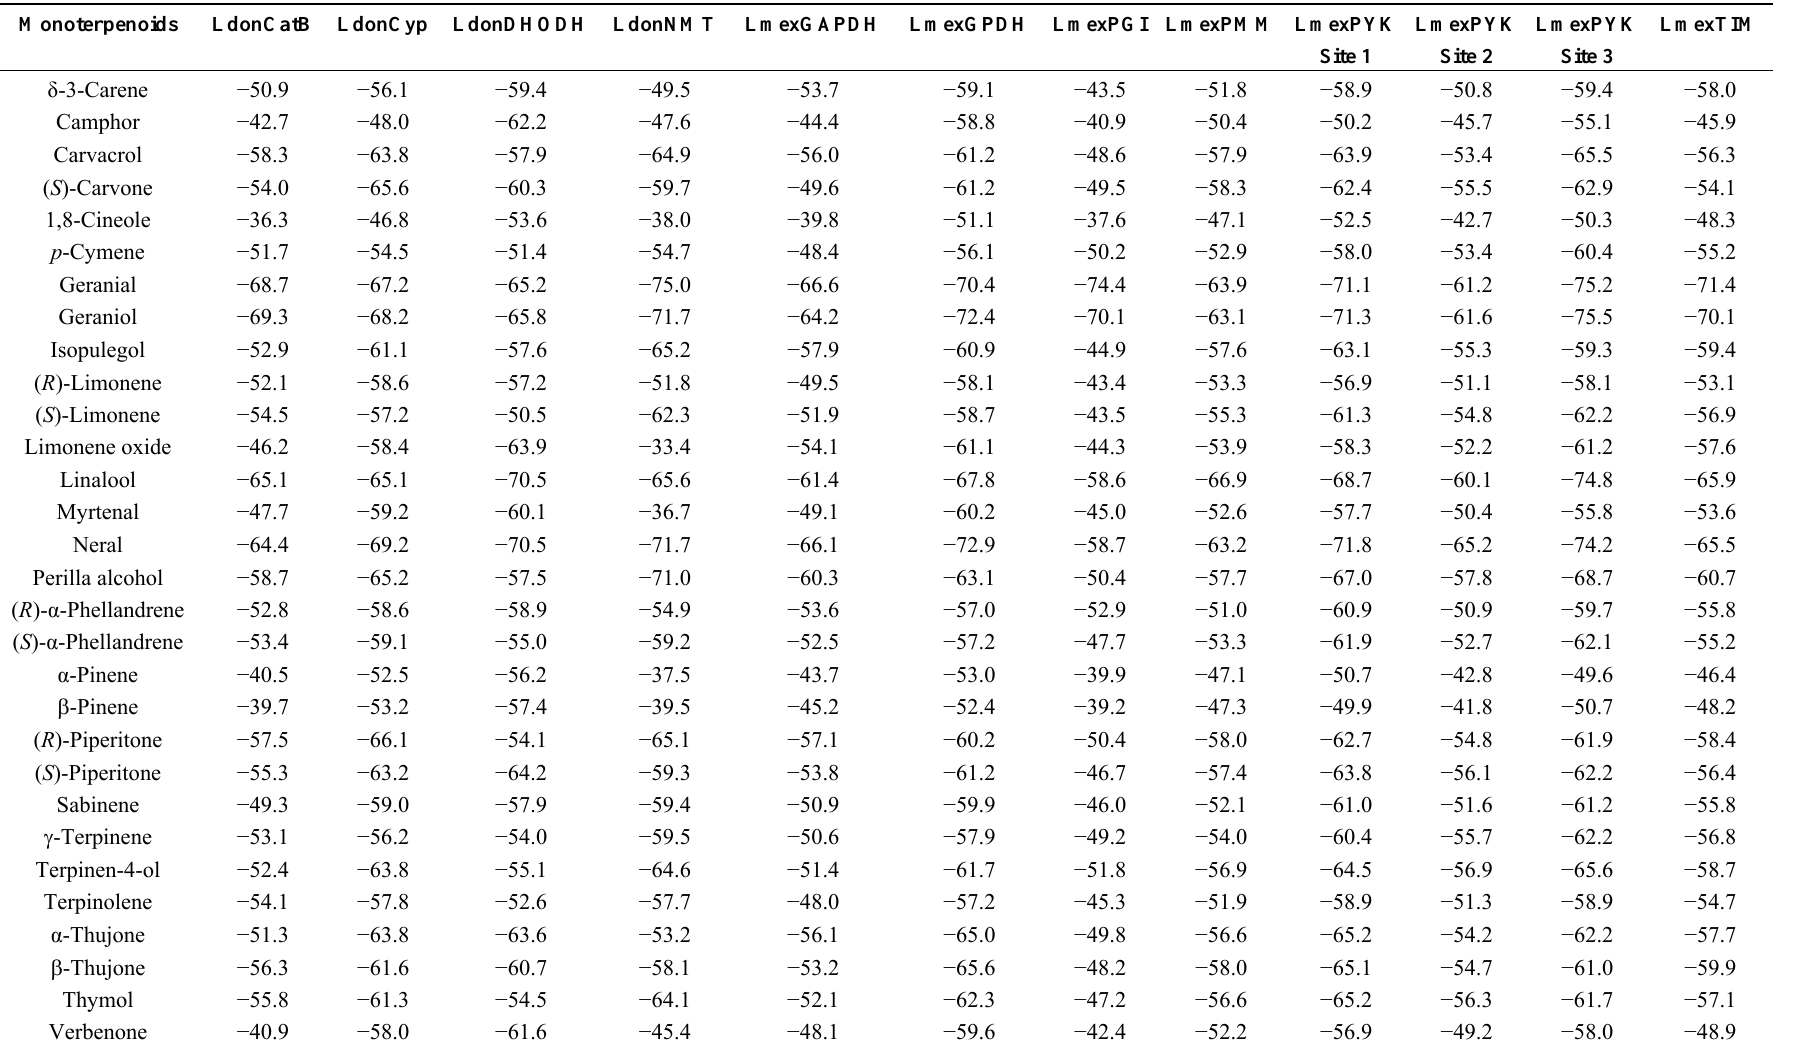
Table 2. MolDock docking energies (kJ/mol) of monoterpenoids with Leishmania donovani and L. mexicana protein targets.